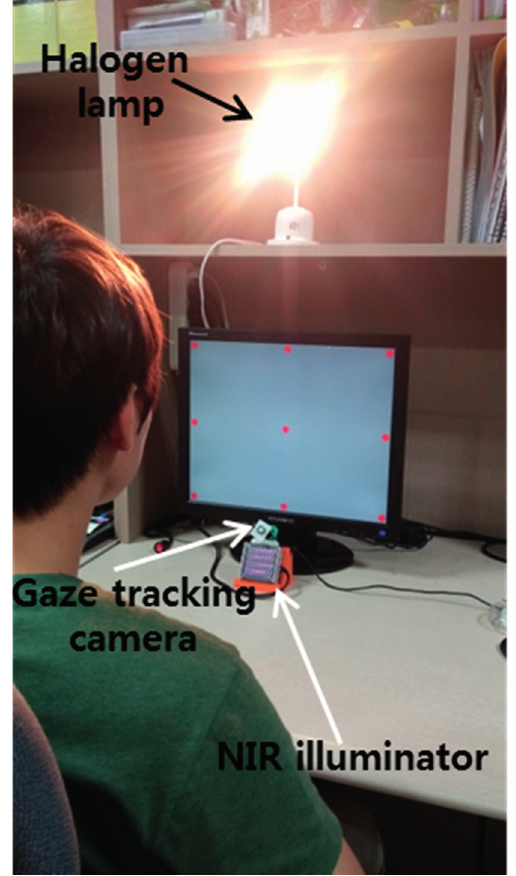
Figure 19. Experimental setup for measuring gaze tracking accuracy under a halogen lamp.